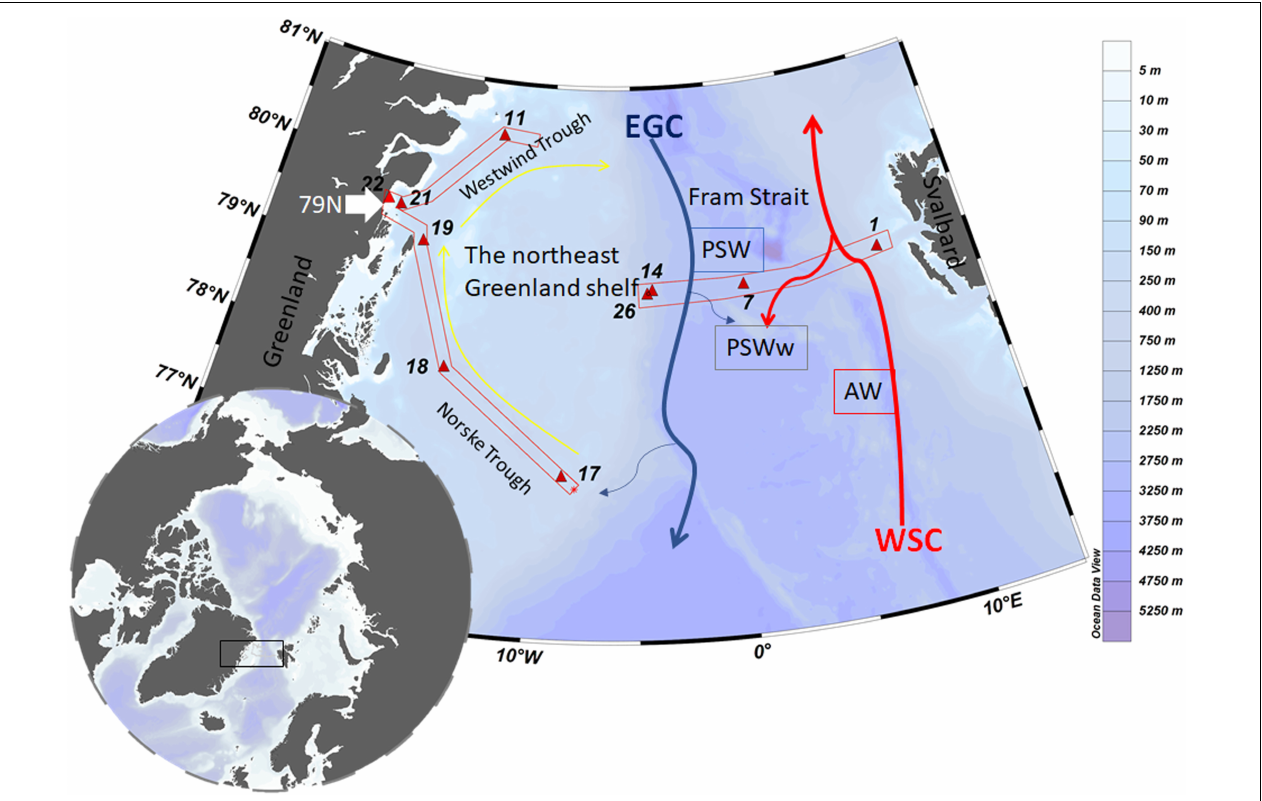
FIGURE 1 | Map of the study area and schematic currents in Fram Strait. The black square indicates the sampling location, and stations are indicated by red triangles. The West-Spitsbergen Current (WSC, red arrows) brings warm Atlantic Water (AW) into the Arctic Ocean. The southward flowing East Greenland (EGC, gray arrows) carries part of the recirculated WSC as well as outflow waters from the Arctic Ocean. The anti-cyclonic circulation through the Norske – Westwind Trough system is indicated by yellow arrows. These schematic currents are simplified from Schaffer et al. (2017) and based on Bourke et al. (1987). Figure was made using the software Ocean Data View (Schlitzer,